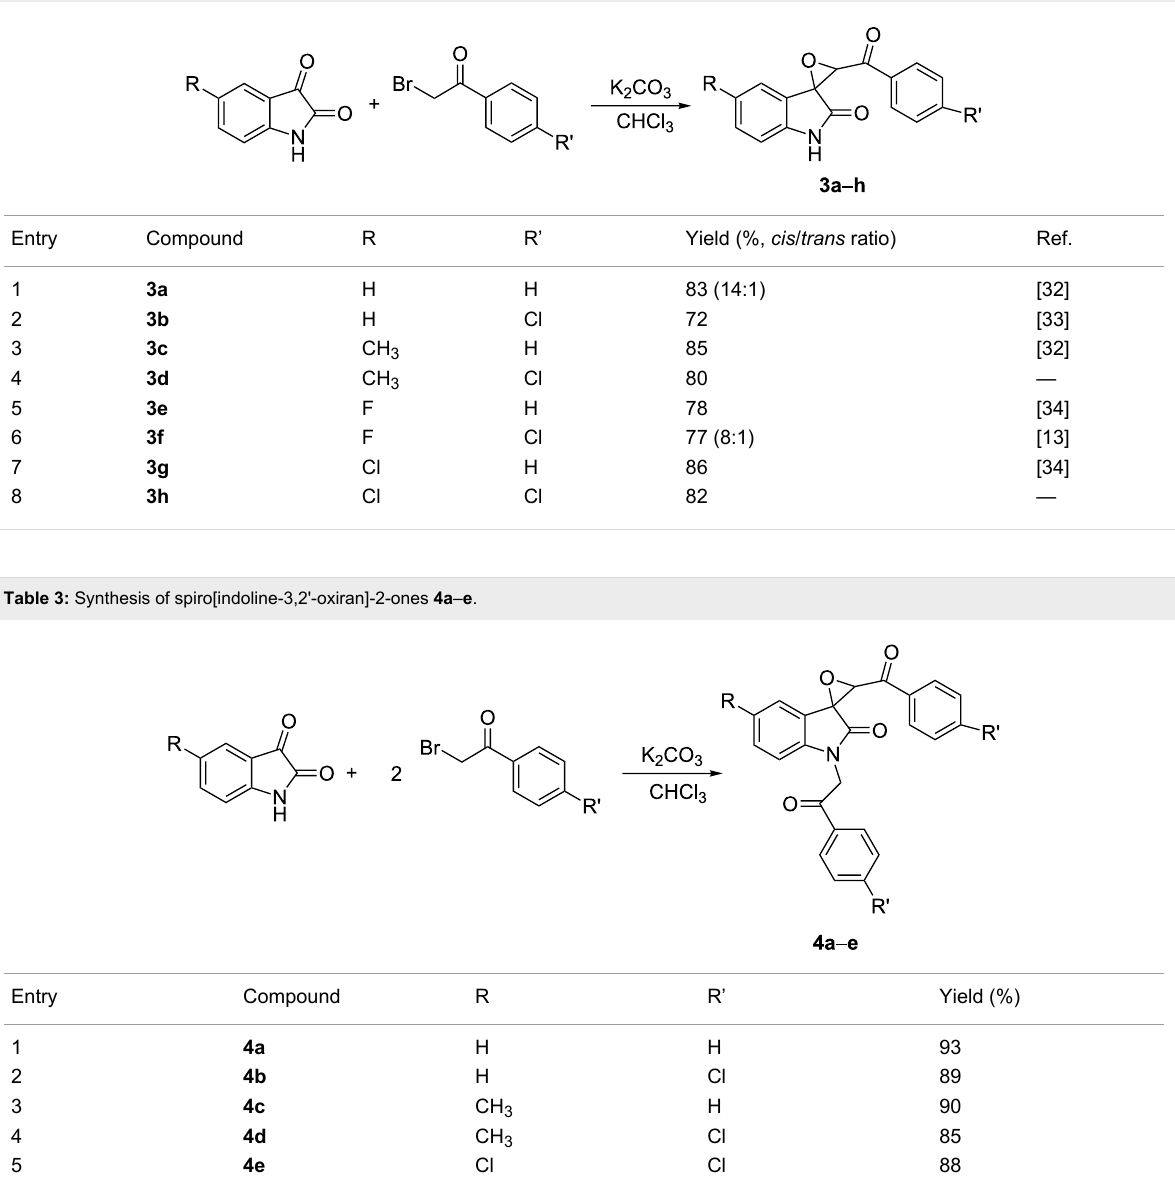
Table 2: Synthesis of spiro[indoline-3,2'-oxiran]-2-ones 3a – h .